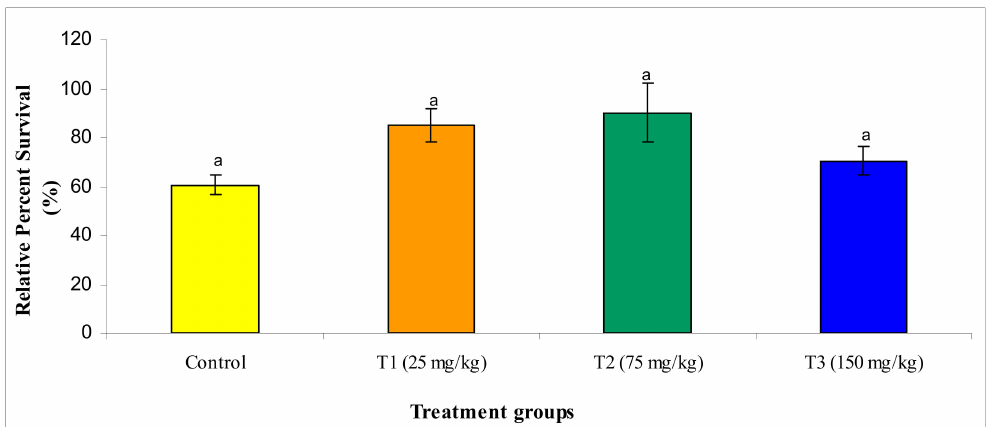
Figure 8. E ff ect of methanol extract of Chaetomorpha antennina administered on the relative percent survival in Labeo rohita challenged with virulent Edwardsiella tarda (mean ± SE). a Mean values with di ff erent superscripts considered as statistically di ff erent ( p < 0.05); n = 6 for each treatment group.